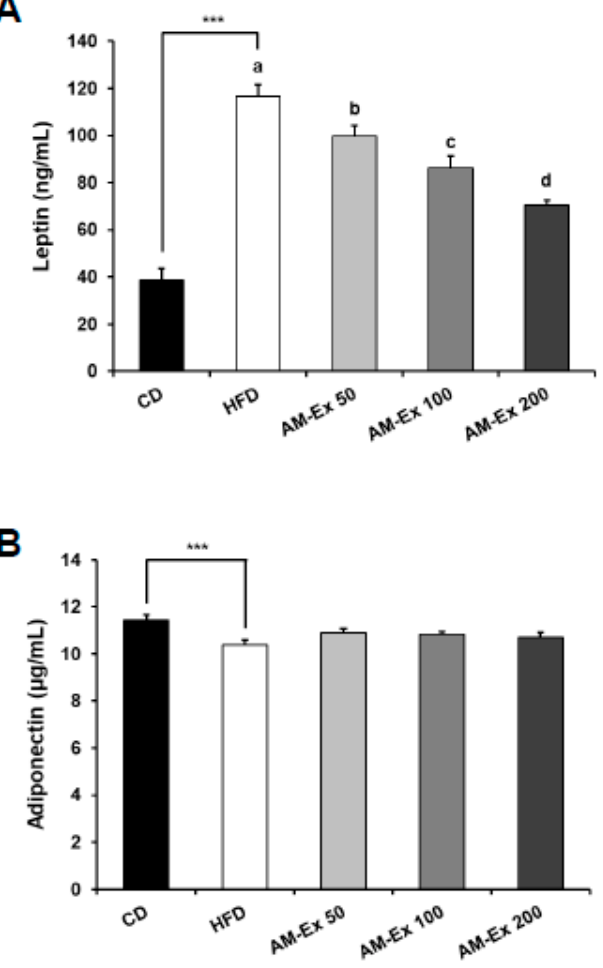
Figure 3. E ff ect of AM-Ex administration on the serum leptin and adiponectin levels in HFD-fed C57BL / 6N mice. AM-Ex was administered by oral gavage for eight weeks while the mice were fed the HFD. The serum levels of leptin ( A ) and adiponectin ( B ) were measured with the appropriate enzyme-linked immunosorbent assay (ELISA) kit. Each bar represents the mean ± SEM (n = 10). * P < 0.05, ** P < 0.01, *** P < 0.001 significantly different from the CD group. Means without a common letter differ between HFD, AM-Ex 50, AM-Ex 100, and AM-Ex 200 groups at P < 0.05.